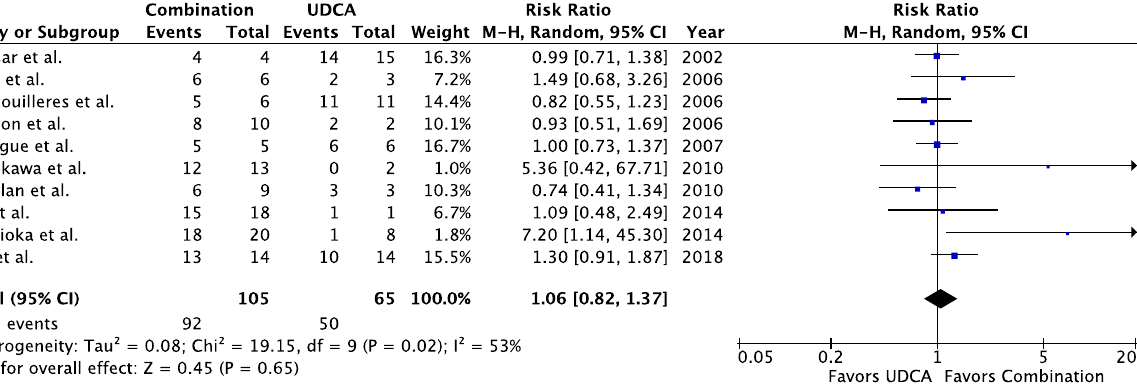
Figure 3. Non-progression of liver fibrosis in AIH-PBC patients treated with combination therapy vs. UDCA alone. UDCA = ursodeoxycholic acid, Combination = UDCA + corticosteroids  AZA.